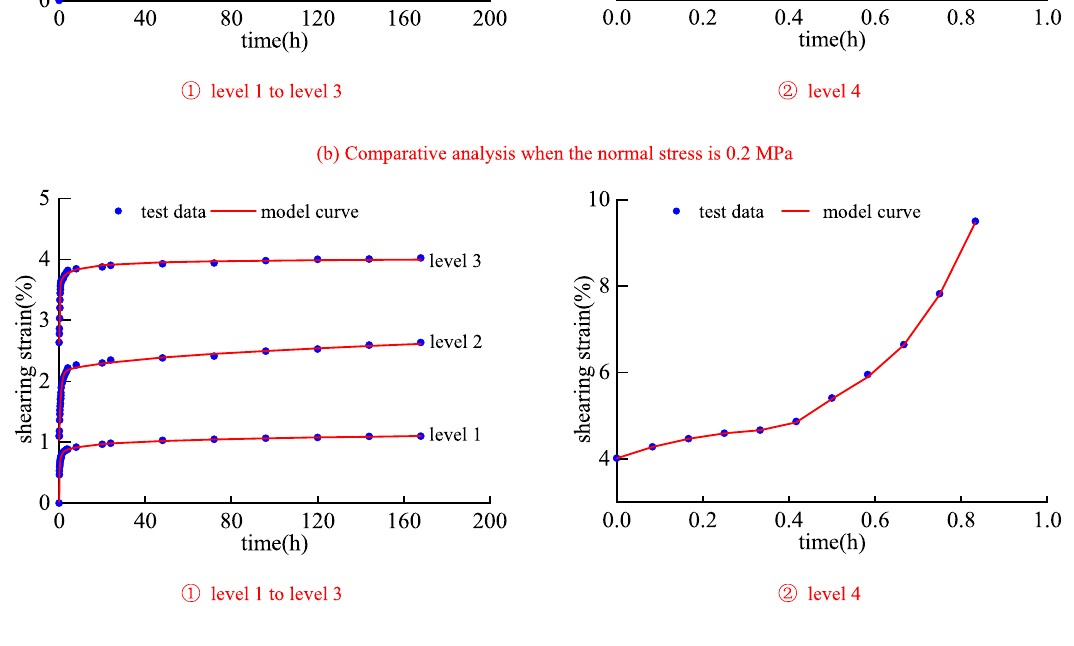
Figure 8. Comparative analysis between the model curve and the test